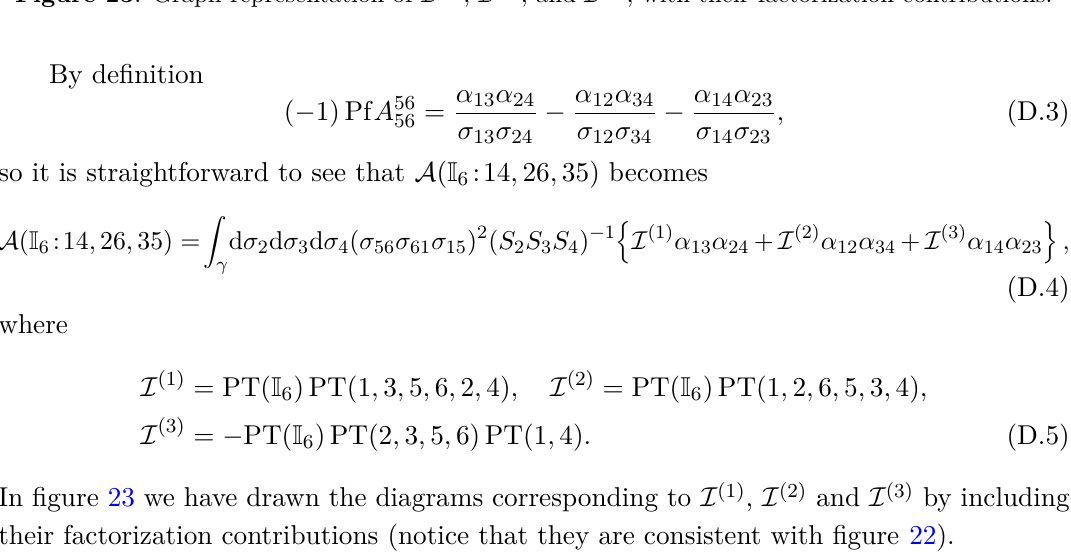
Figure 23 . Graph representation of I (1) , I (2) , and I (3) , with their factorization